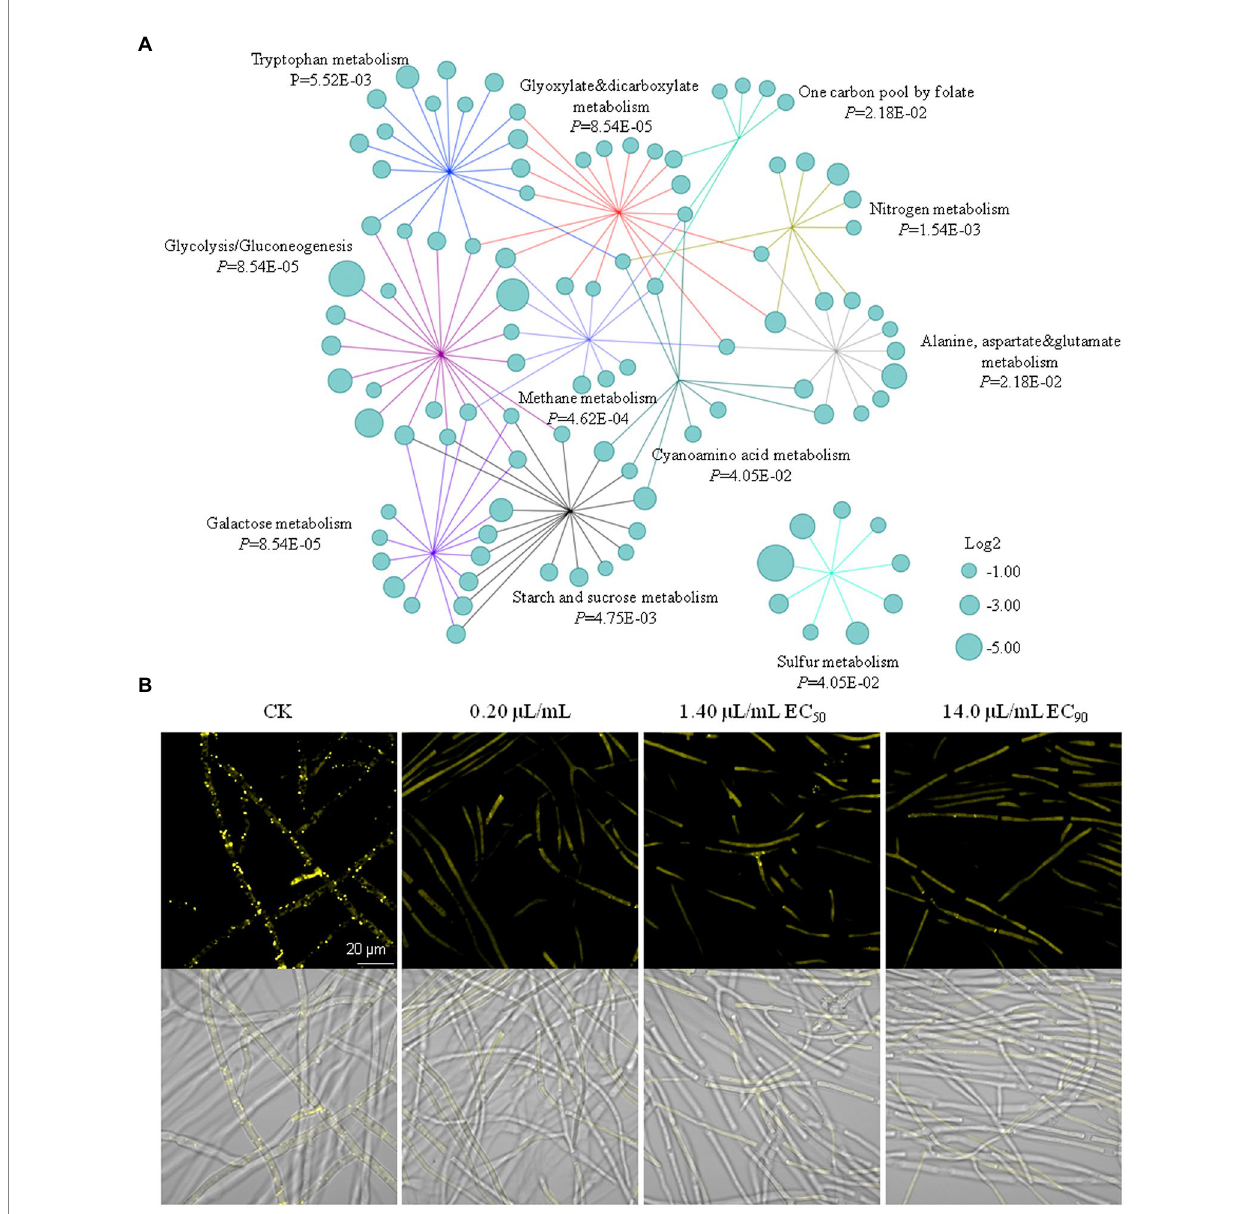
FIGURE 4 Limonene formulation inhibited the energy metabolism pathways and lipid droplets formation in Fusarium graminearum . (A) Network analysis of the relationship between significantly down-regulated genes and the corresponding enriched KEGG pathways. The cyan circle indicated different gene. Involvement of these genes in different metabolism pathways was visualized with colored lines representing each pathway. The relative fold change (log2-transformed) of gene expression is indicated by the circle size. (B) Limonene formulation inhibited the accumulation of lipid droplets in the